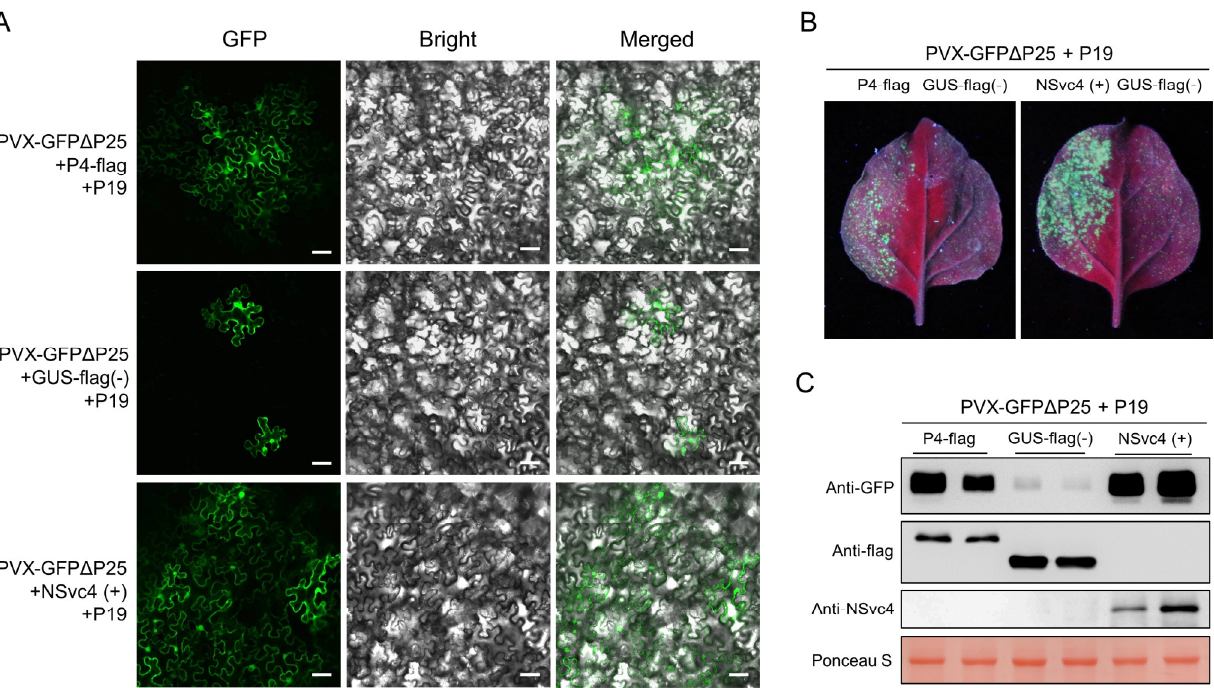
Figure 5. PSCYV P4 can complement the intercellular movement of mutant PVX-GFPΔP25. ( A ) PSCYV P4 can complement the intercellular movement of mutant PVX-GFPΔP25. The co-infiltrated N. benthamiana leaves were observed with a confocal microscope at 7 dpi. Bars, 50 μm. ( B ) GFP fluorescence of co-infiltrated N. benthamiana leaves was observed under a UV lamp at 7 dpi. ( C ) Western blot assays analyzing GFP and viral protein accumulation levels in co-infiltrated leaves. The large RuBisCO subunit stained by Ponceau S served as the loading control.